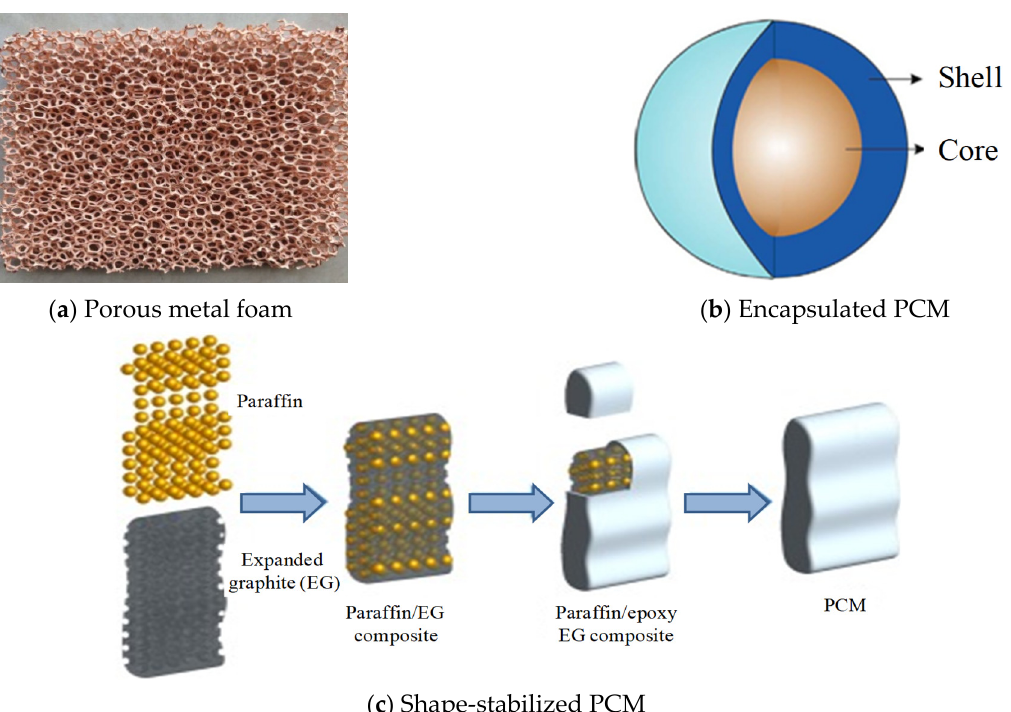
Figure 14. PCMs incorporation techniques [20,103–105], reprinted/adapted with permission from Refs. [20,103], 2022, Elsevier.